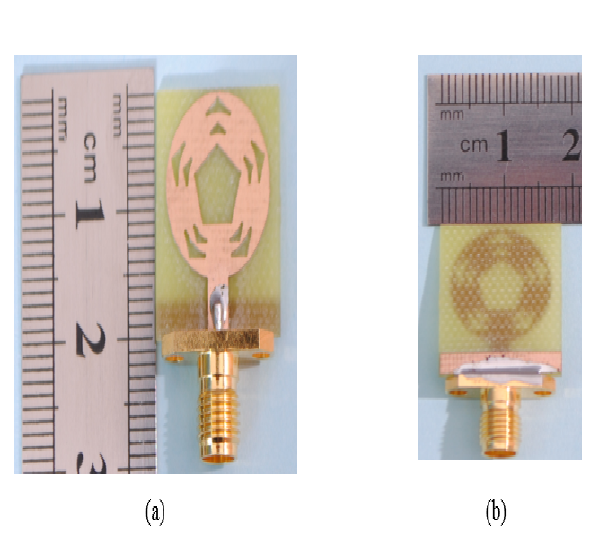
Figure 8 Fabricated Prototype of Proposed Antenna (a) Top View (b) Bottom View